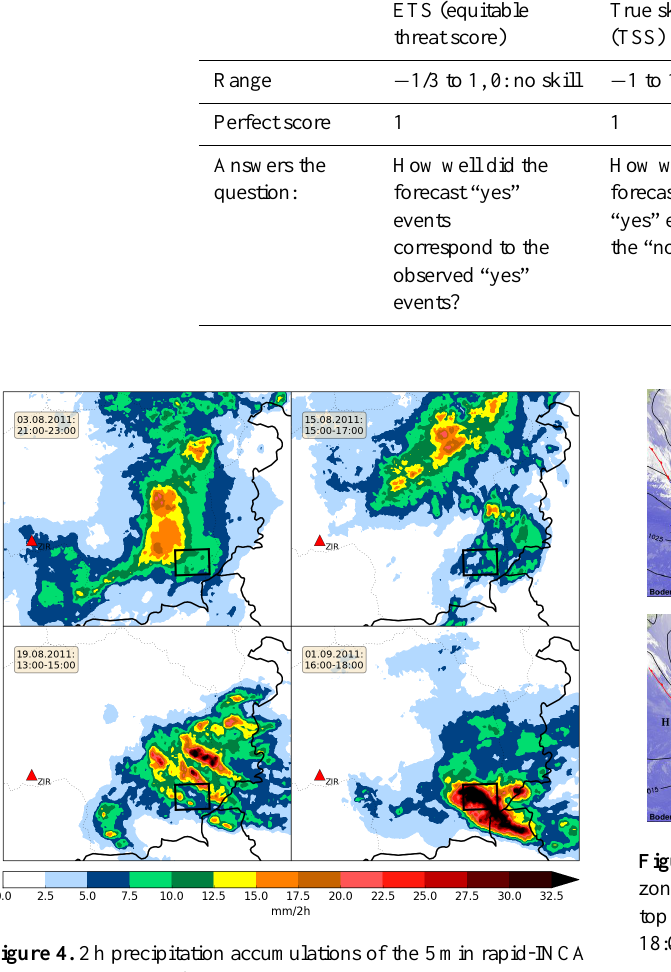
eastern parts of the